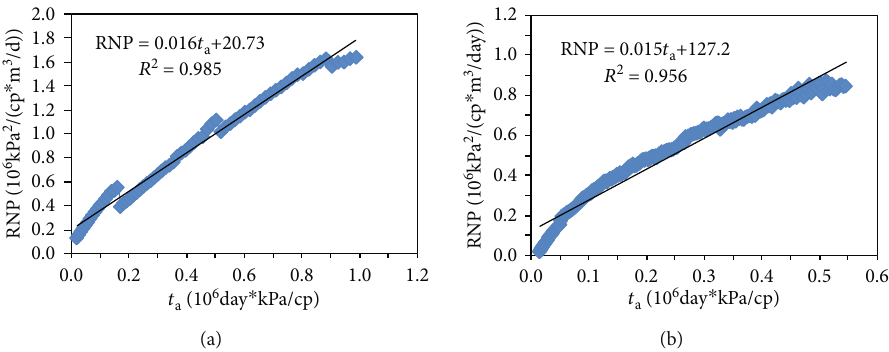
Figure 13: Analysis without considering stress sensitivity of EGP data of two wells in shale gas belonging to southern Sichuan: rate- normalized pressure change with pseudotime. (a) Well 3 and (b) Well